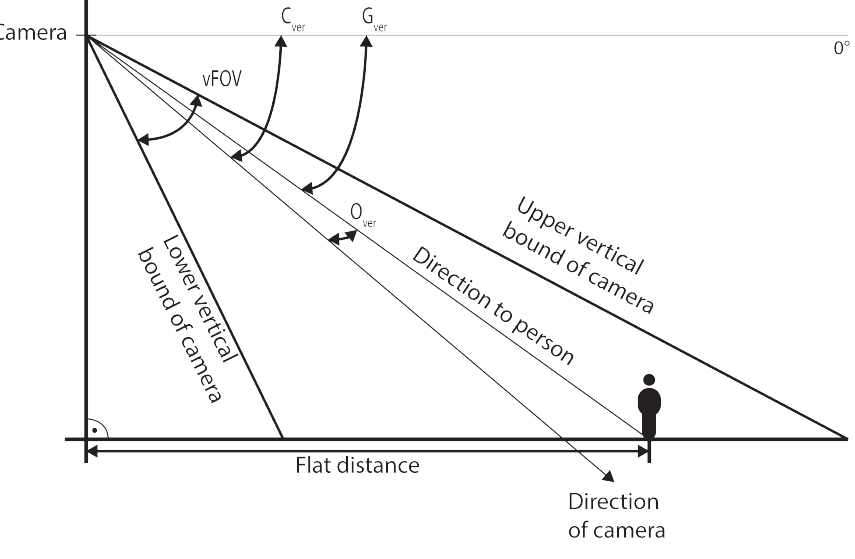
Figure 3. Vertical